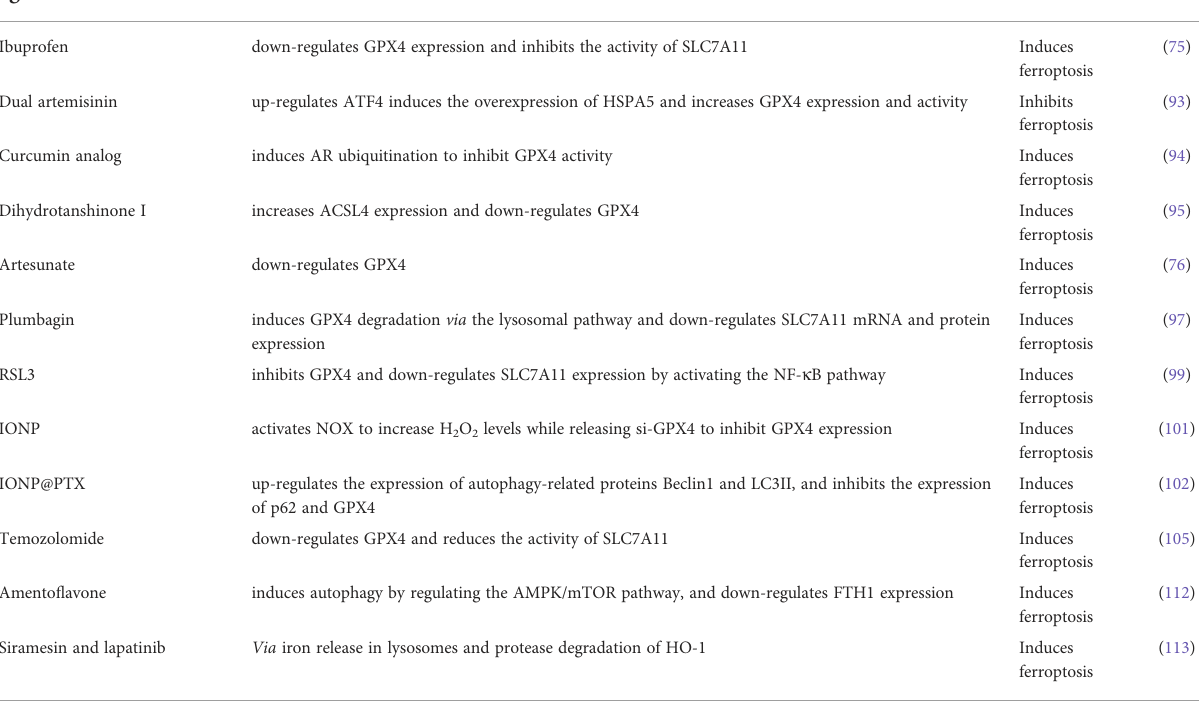
TABLE 1 Summary of ferroptosis-associated